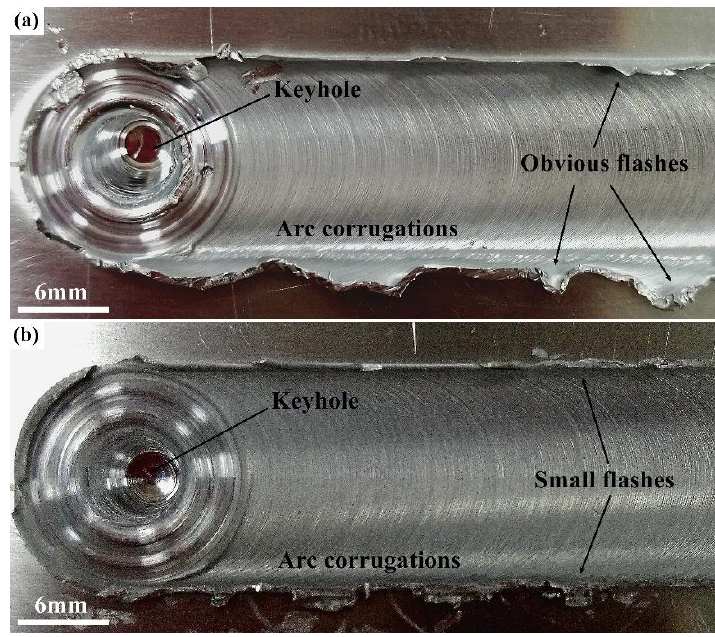
Figure 2. Surface appearances of ( a ) Al/Mg and ( b ) Al/Zr/Mg joints.